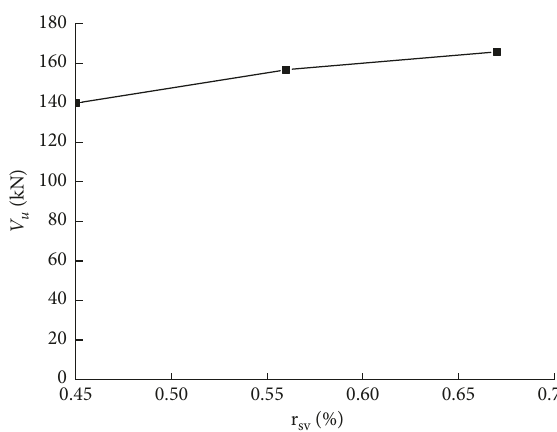
Figure 9: Relation of shear strength and r